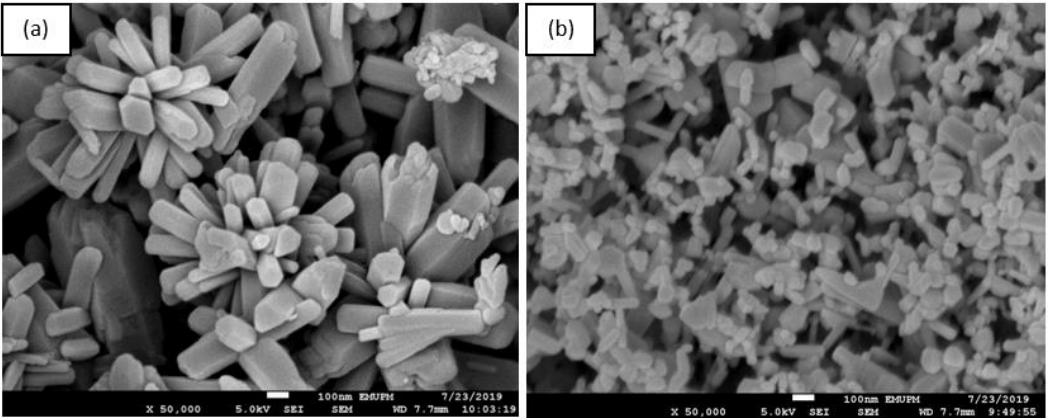
Figure 5. FESEM images of synthesized ZnO NPs observed at 50,000×: ( a ) heated (60 °C) and ( b ) non-heated (28 °C).